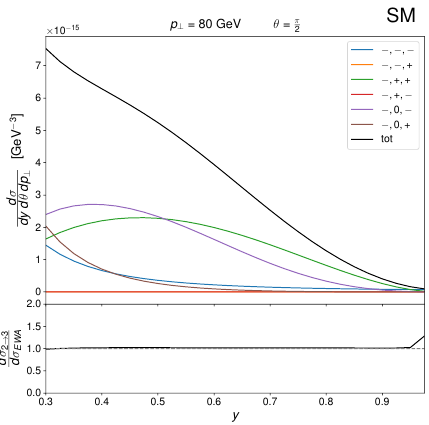
Figure 3. The SM contribution in various ( (cid:21) cross section as a function of the hard-scattering energy fraction y = p ^ s= 2 E